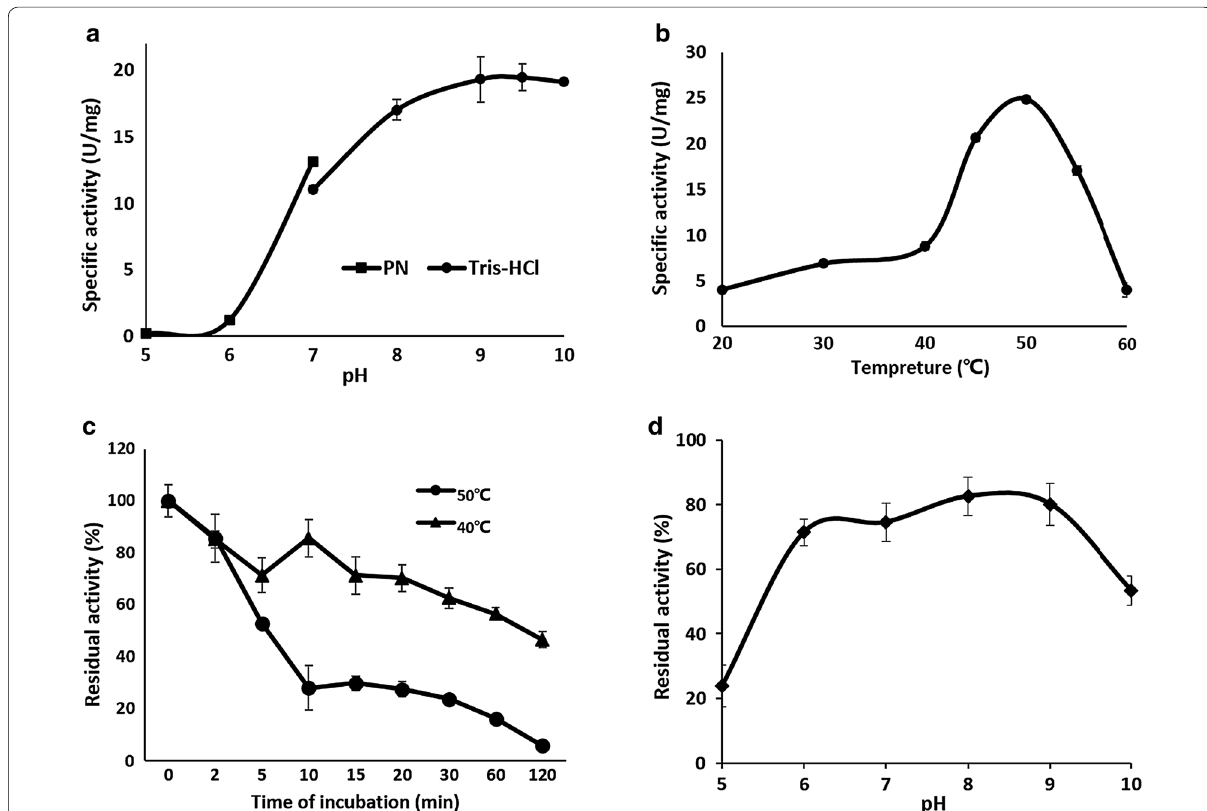
Fig. 5 Biochemical characterization of Tl LipA. a The pH-activity profiles determined in citric acid-Na 2 HPO 4 (black square) and Tris–HCl (black circle) buffers. b The temperature-activity profile determined in Tris–HCl buffer at pH 9.5. c The thermal stability at 50 °C (black circle) and 40 °C (blackup-pointing triangle). d The pH stability after 1-h incubation at 37 °C and pH 5.0–10.0